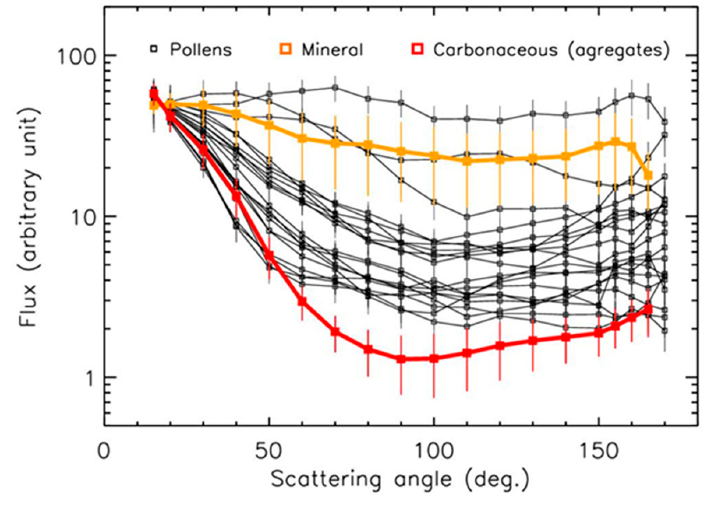
Figure 11. Intensity curves in the red domain for the pollens compared to various mineral and car- bonaceous